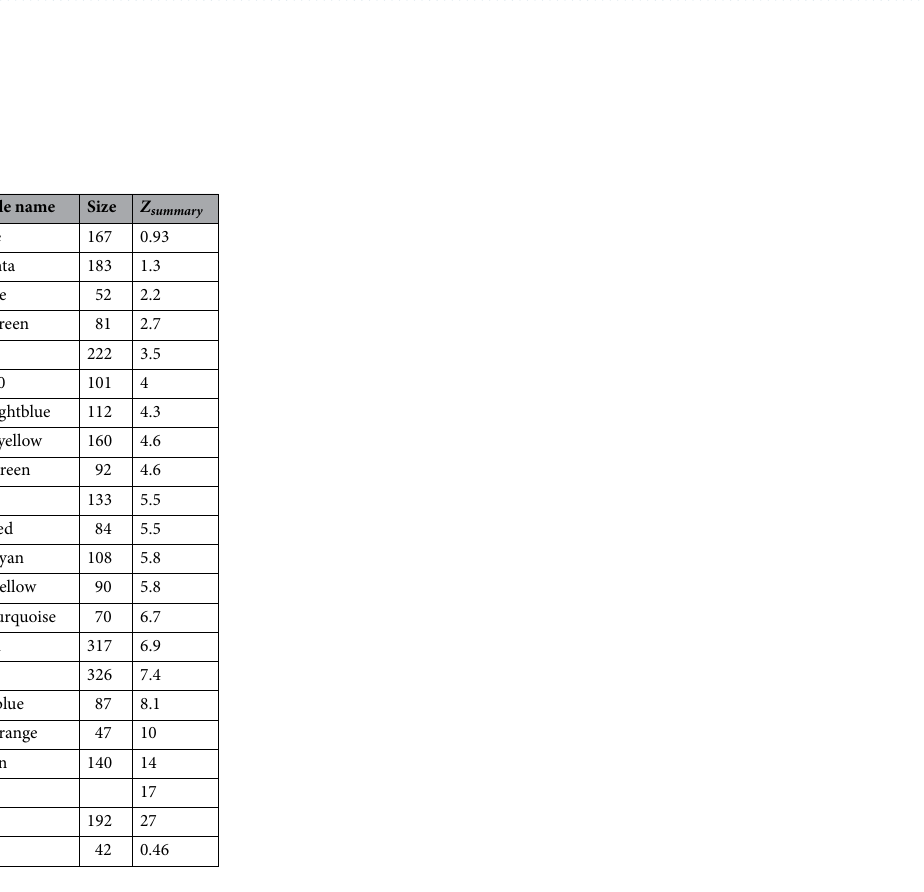
Table 1. The Z summary of NSCLC co-expression modules compared to the normal gene expression